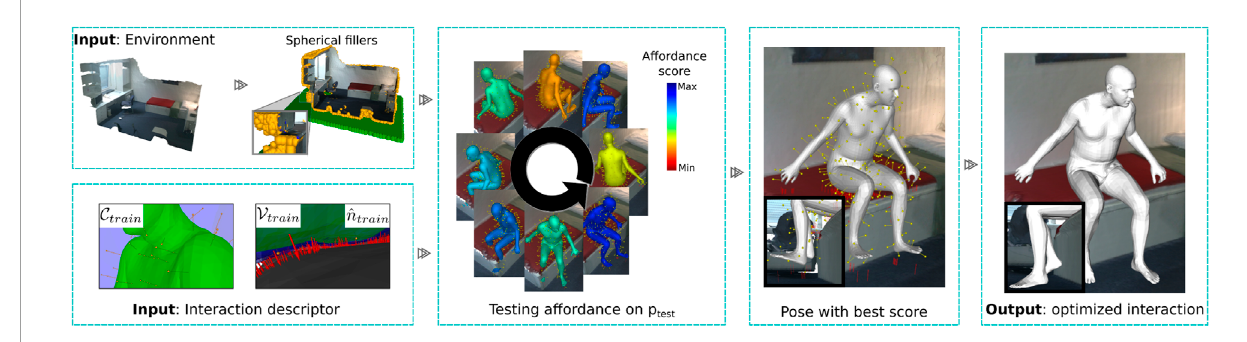
FIGURE 3 Approach for detecting human affordances. To mitigate 3D scan noise, the scene is augmented with spherical fillers for detecting collisions and SDF values. Our method detects if a test point in the environment can support an interaction by translating the descriptor to the test position over different orientations and measuring its alignment and collision rate. Then, the best-scored configuration is optimized to generate a more natural and physically plausible interaction with the environment.